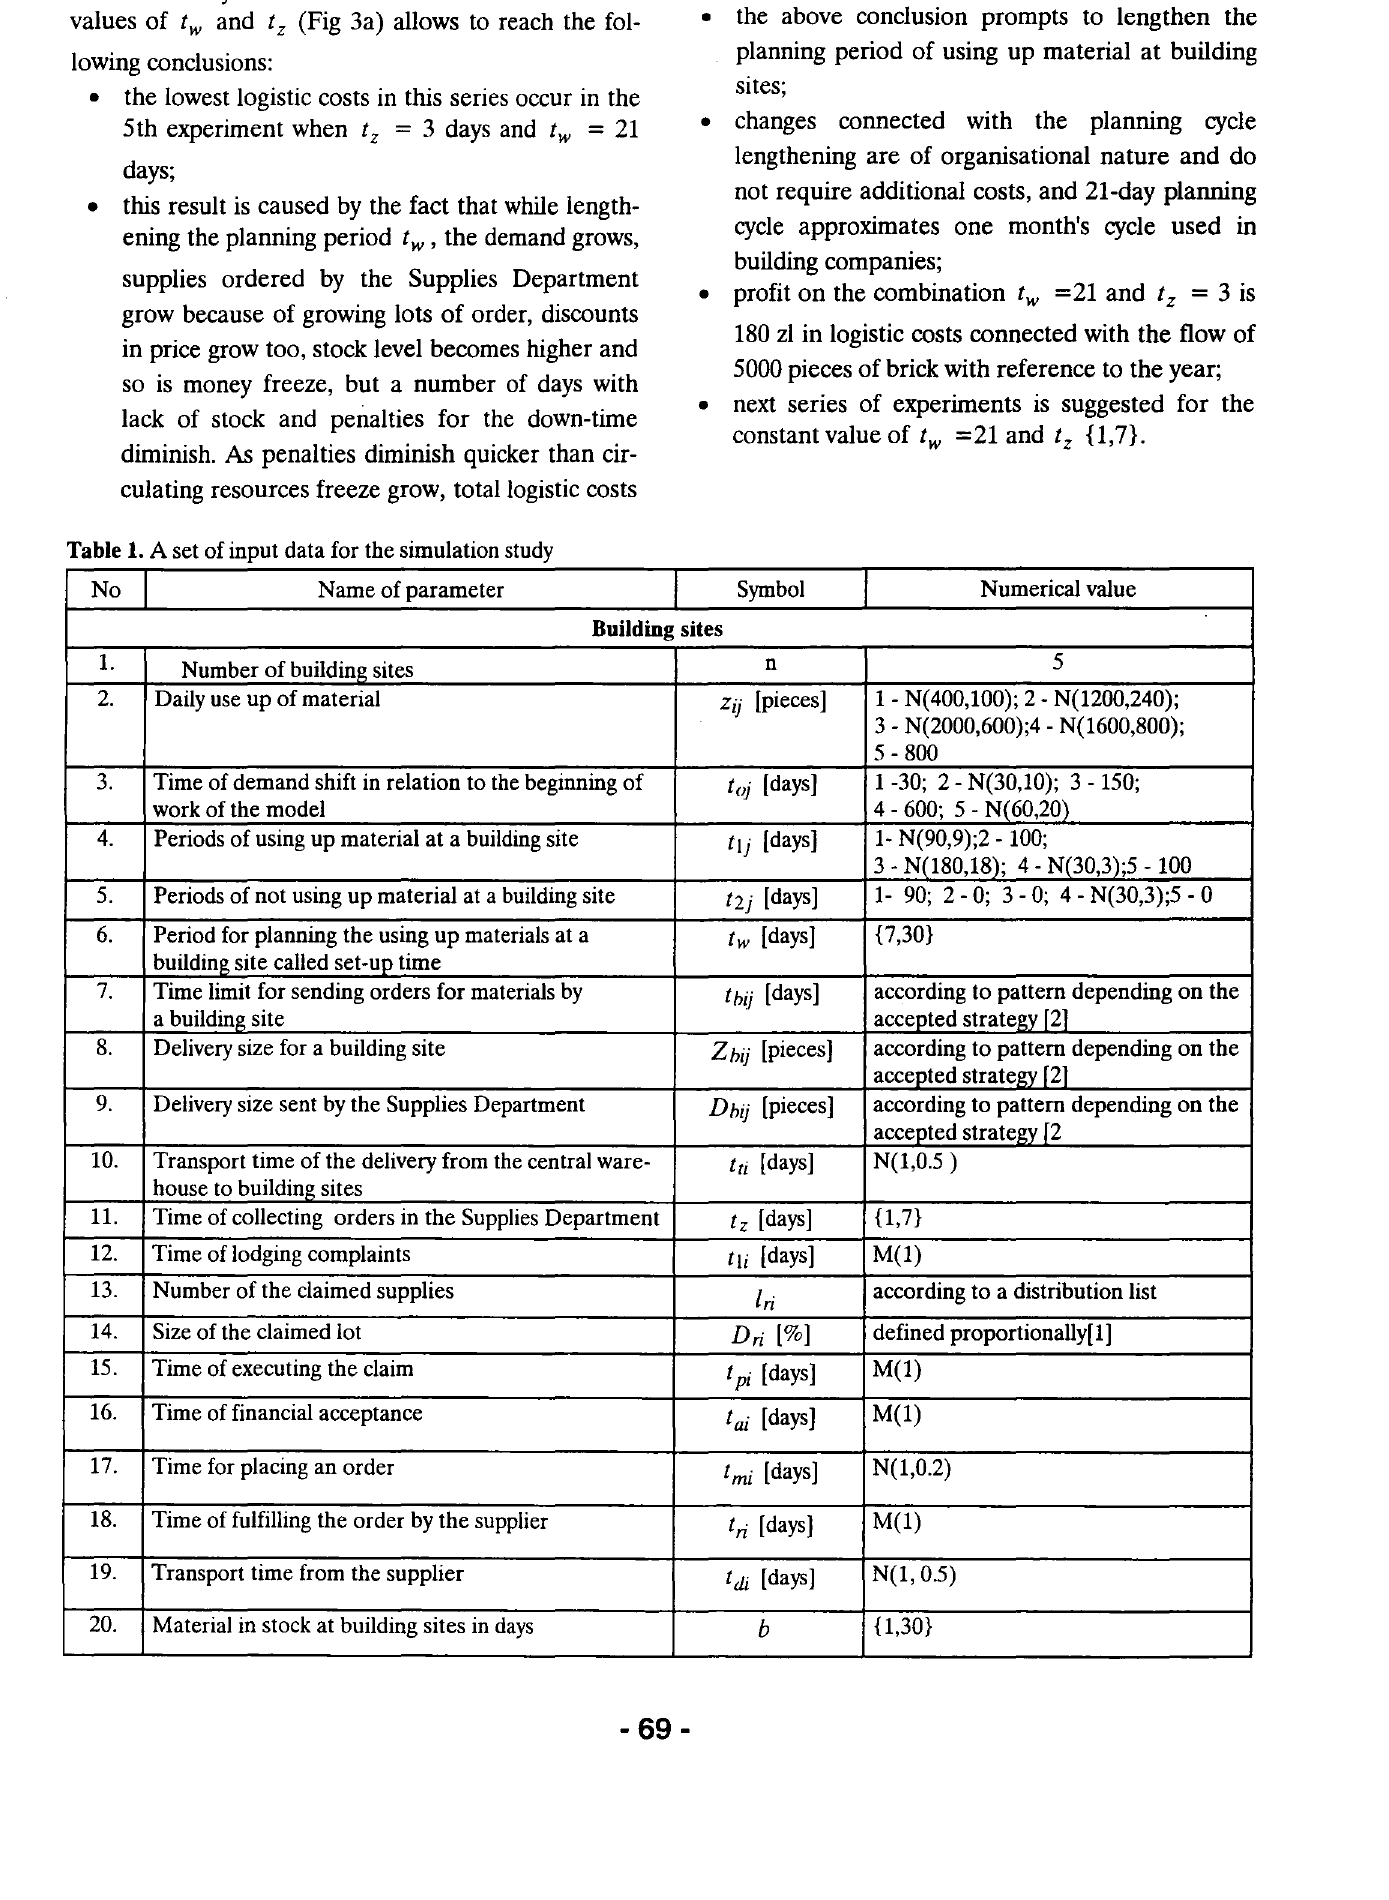
Table 1. A set of input data for the simulation